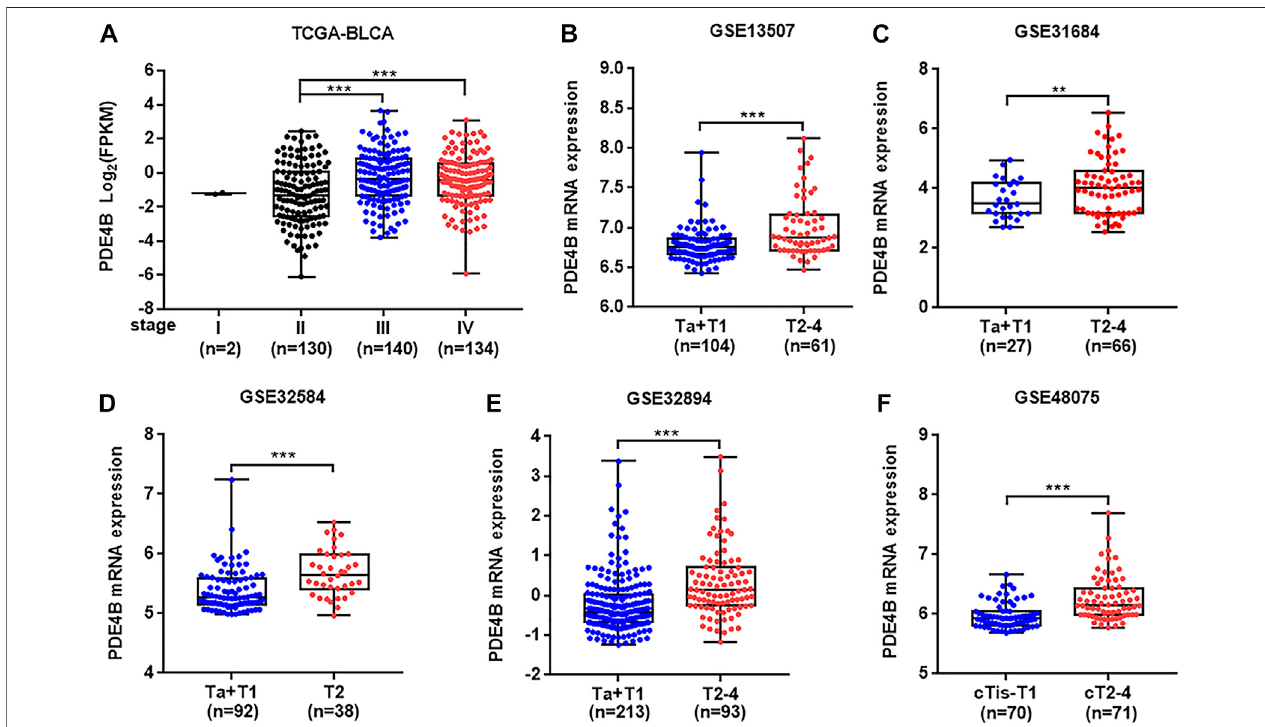
FIGURE 1 | PDE4B expression is upregulated in advanced stage patients with UBC. (A – F) The comparison of PDE4B mRNA level in different tumor stage of UBC patients from TCGA-BLCA (A) , GSE13507 (B) , GSE31684 (C) , GSE32584 (D) , GSE32894 (E) , and GSE48075 (F) databases. ** p < 0.01, *** p < 0.001.